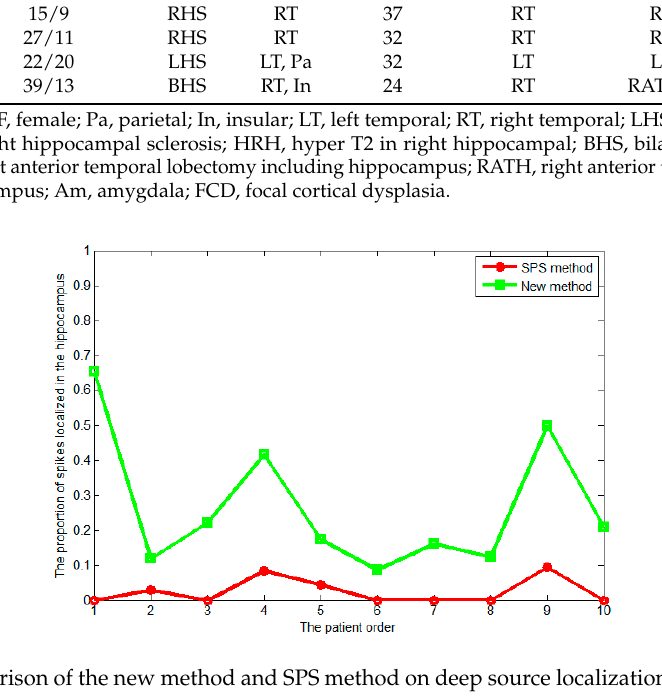
Figure 5. Comparison of the new method and SPS method on deep source localization results, in which the x-axis represents the patient sequence, and the y-axis represents the ratio of the number of spikes localized in the hippocampus to the total number of spikes on each patient.